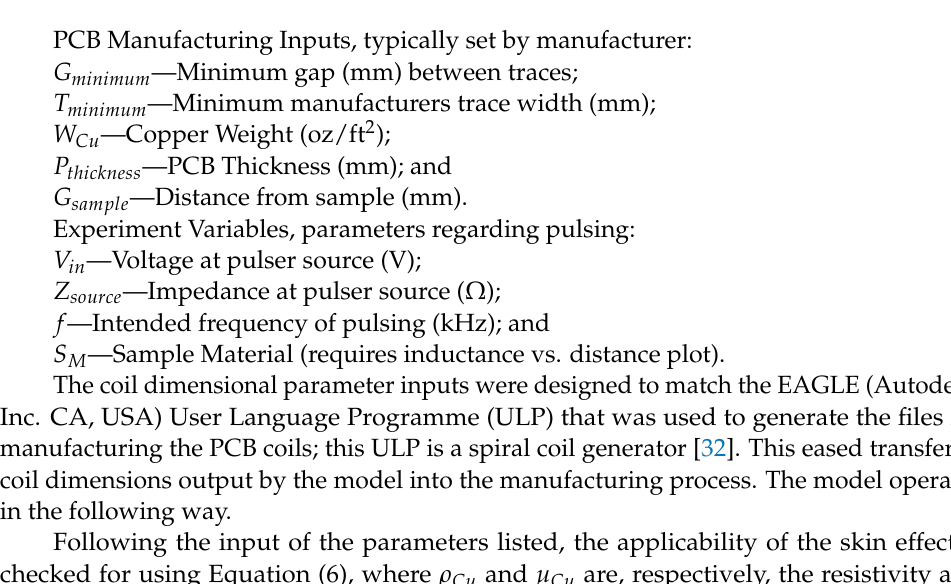
Figure 2. Geometrical coil input parameters for the numerical model, shown diagrammatically.